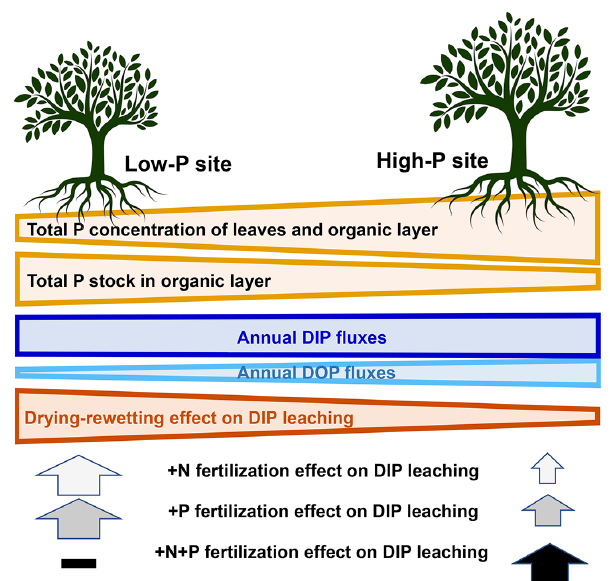
Figure 5. Summary graph of the effects of fertilization and drying– rewetting on dissolved inorganic and organic phosphorus (DIP and DOP) annual fluxes from the organic layers, dependent on the two study sites that exhibit contrasting